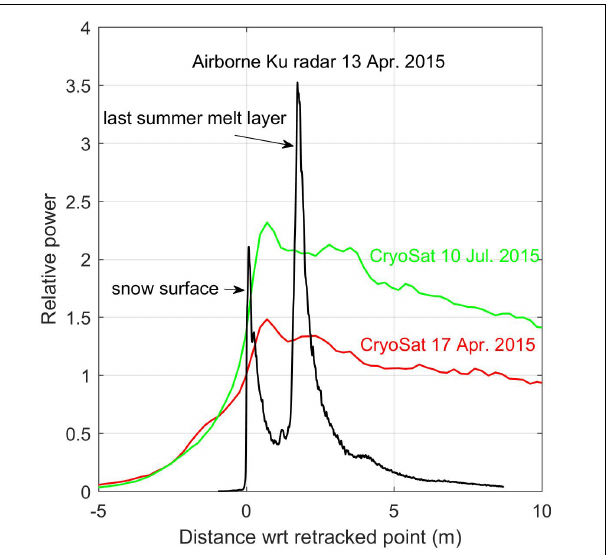
FIGURE 7 | Comparison of CryoSat (red and green), and airborne Ku-band altimeter waveforms (black) from close to the intersection of IceBridge flight lines CD and EF in Figure 8 . The red and green waveform plots are averages of all the CryoSat waveforms from two closely spaced descending passes (EF) on April 17, 2015 and July 10, 2015, between 63.9 ◦ and 64.1 ◦ N. The x axis is range distance from the position estimated from the retracker